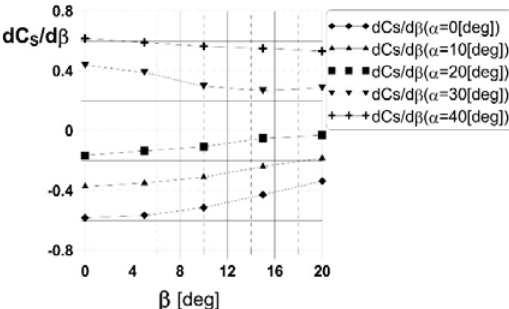
Fig. 13. Roll moment coefficient Cl versus sideslip angle